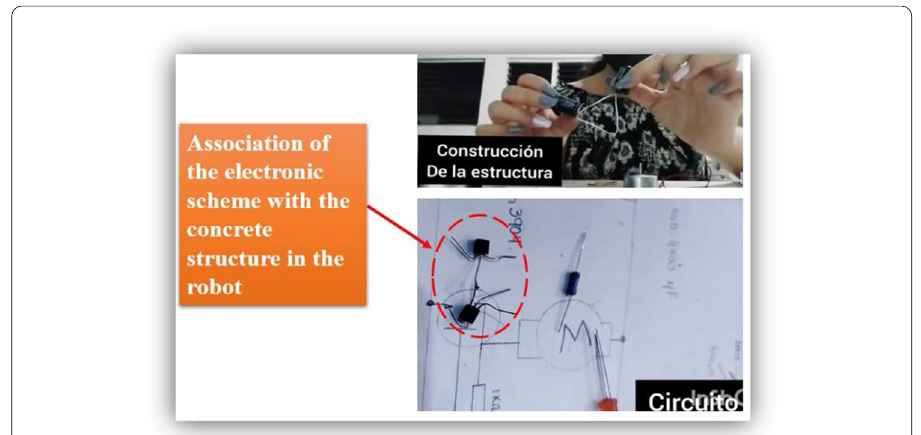
Fig. 12 Images from the video of one of the six students that included the electronic schematic. Activity “Video of the construction of the SYMMET, commenting step by step.”